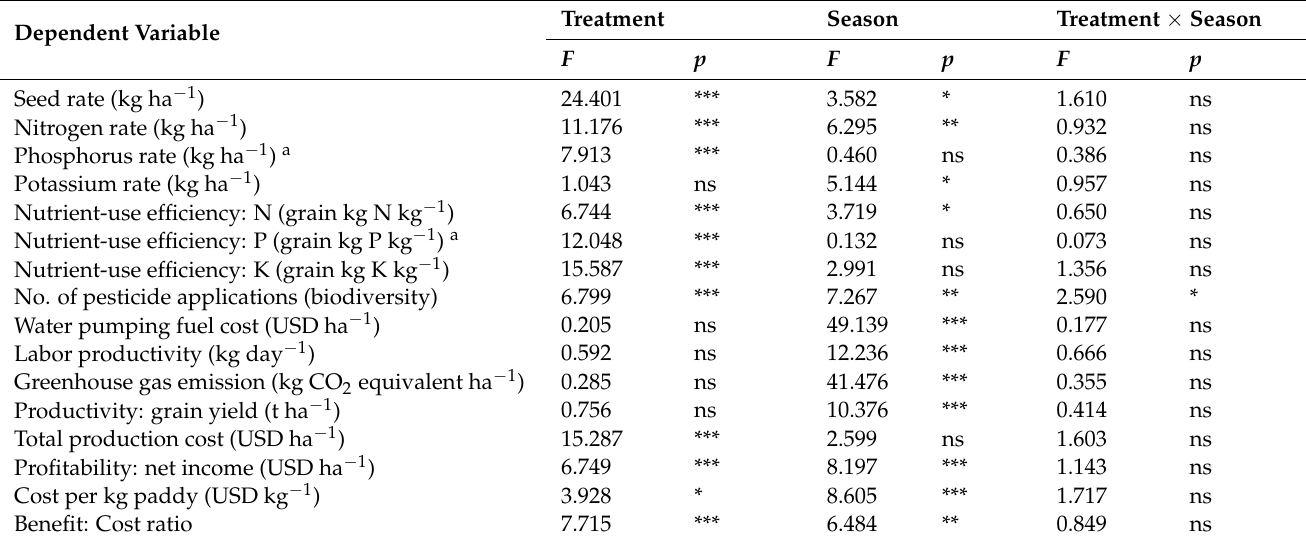
Table 6. Linear mixed model results of the interaction effects of field trial treatment and season on input, output and economic